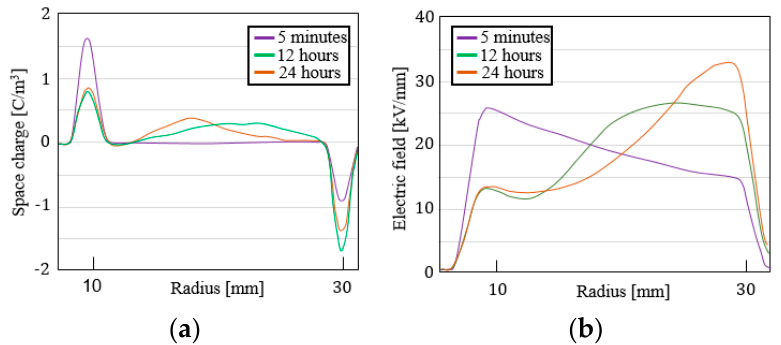
Figure 2. ( a ) Space charge distribution in a full-size cable and ( b ) related electric field profiles.